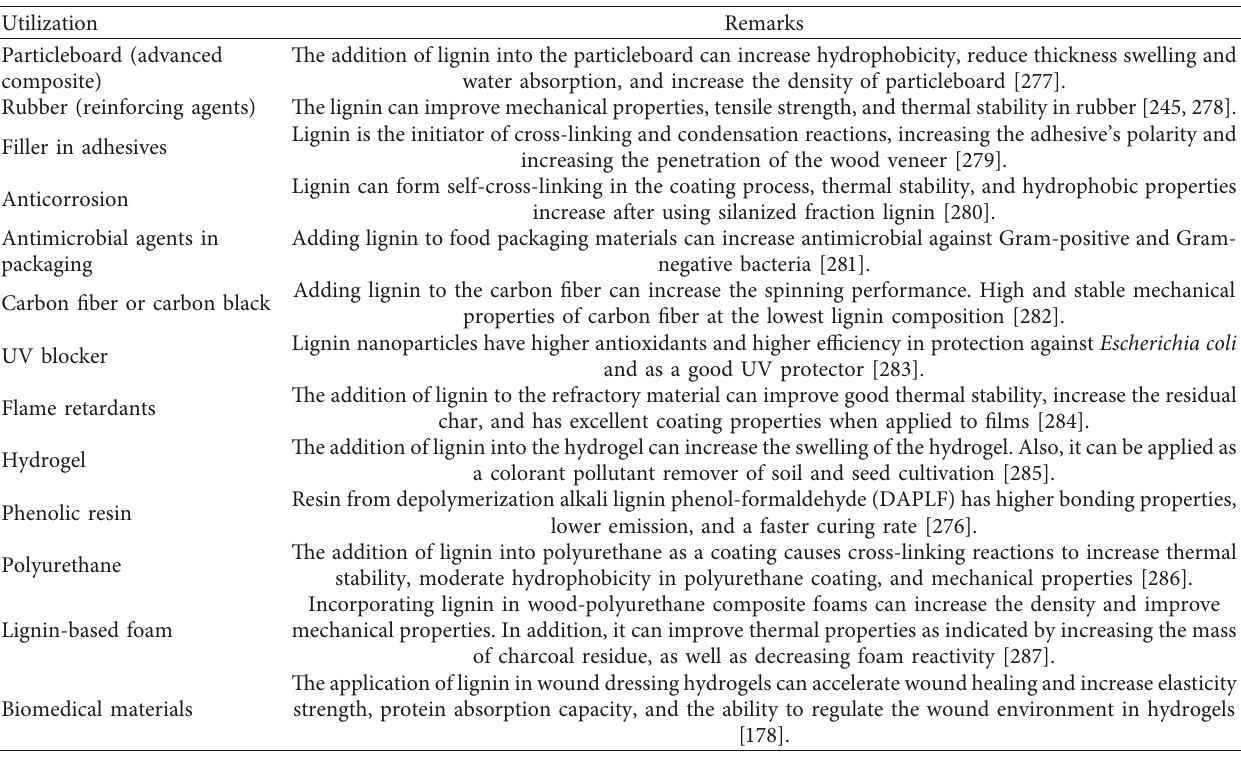
Table 4: The lignin introduction and its